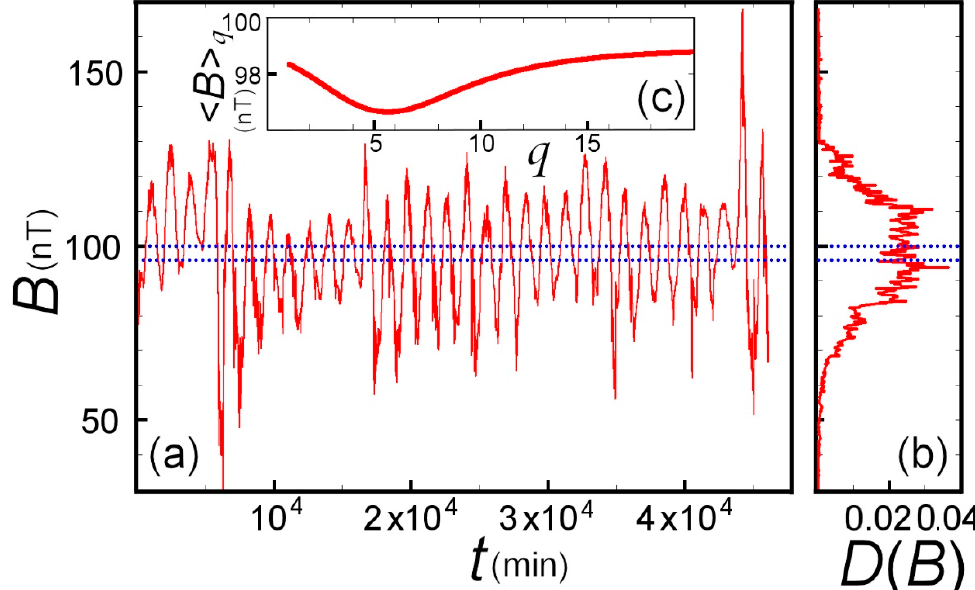
Figure 5. ( a ) Magnitude of the Earth’s magnetic field recorded between 1 / 1 / 2008 and 1 / 2 / 2008. ( b ) Sampling distribution of these time series values. ( c ) L q -expectation values of this dataset plotted against the L q -norm. (Modified from [11]).